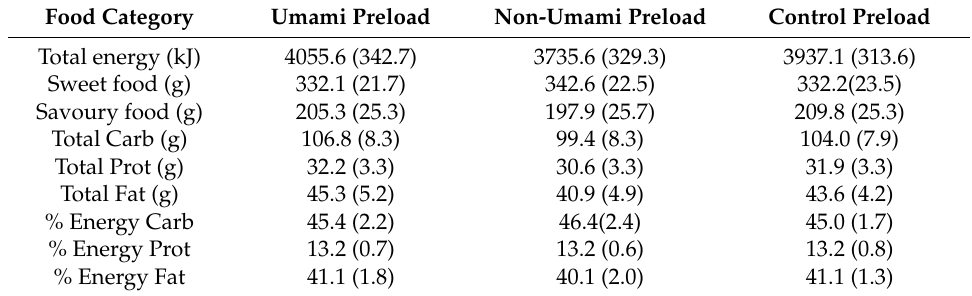
Table 4. Effect of pre-load treatment group (umami, non-umami and control) on the consumption of foods from a buffet meal categorised by macro-nutrient (energy, carbohydrate, protein or fat), taste category (sweet or savoury) or energy contribution (%) ( n = 30